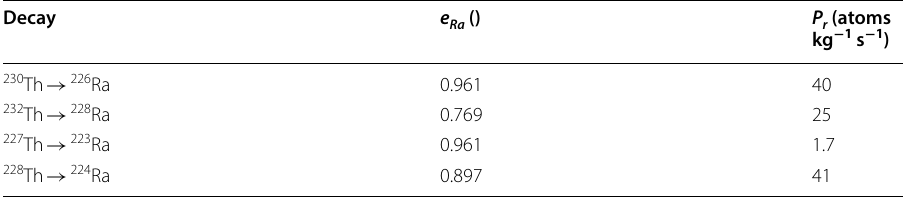
Table 10 Recoil efficiency for radium ( e from Krishnaswami et al. 1982) as well as model-derived rates of alpha-recoil supply ( P for the geothermal system in